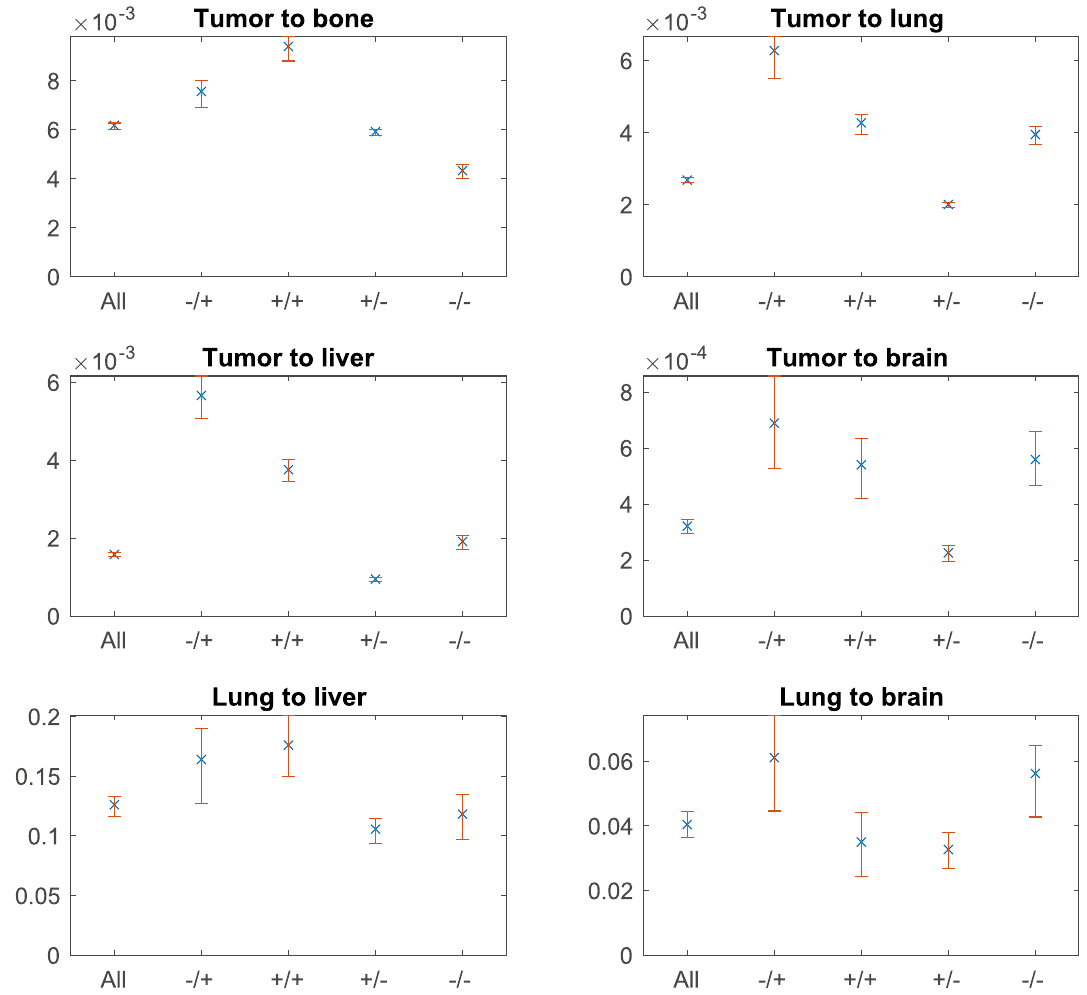
Figure 5. Dissemination rates and their 95% confidence intervals for each parameter. ‘All’ stands for the whole data set, while ‘−/+’ indicates HR−/HER2+, ‘+/+’ indicates HR+/HER2+, ‘+/−’ indicaates HR+/HER2−, ‘−/−’ indicates HR−/HER2−